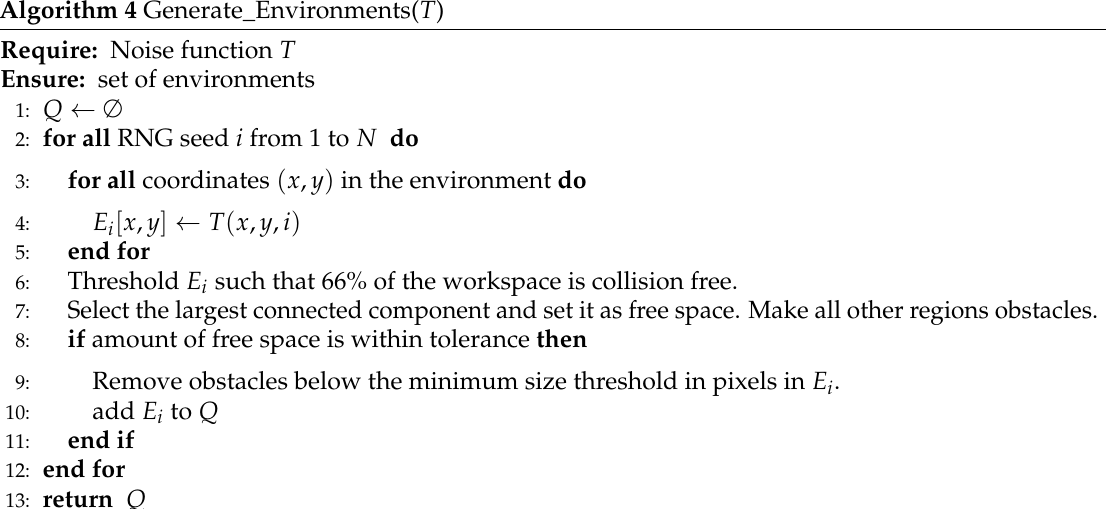
Figure 5. Example Simplex noise using OpenSimplex noise and illustrations on generating natural environments. ( a ) shows 1 frequency band of Simplex noise, while multiple frequency bands create the environment in ( b – d ). The color elevation map in ( b